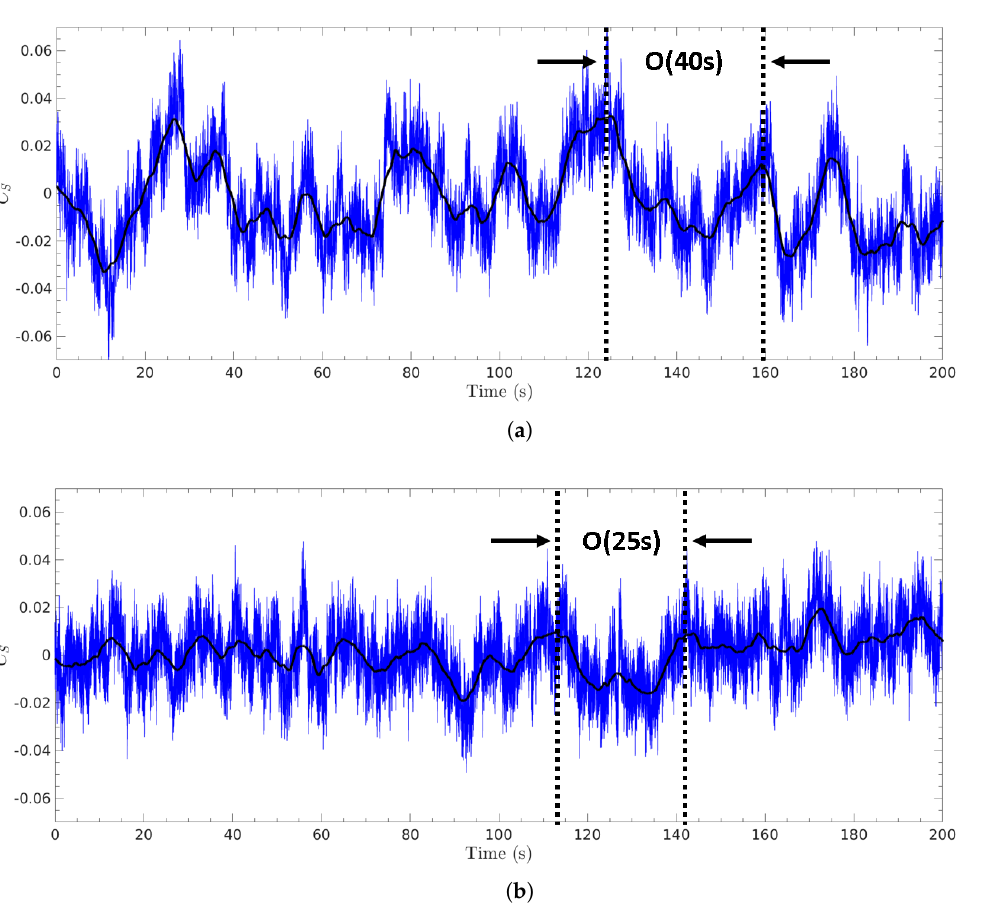
Figure 6. Time trace of the side-force coefficient C S for the ( a ) stationary wheels and ( b ) rotating wheels cases overlayed with a sliding average using a window size associated with St = 0.02